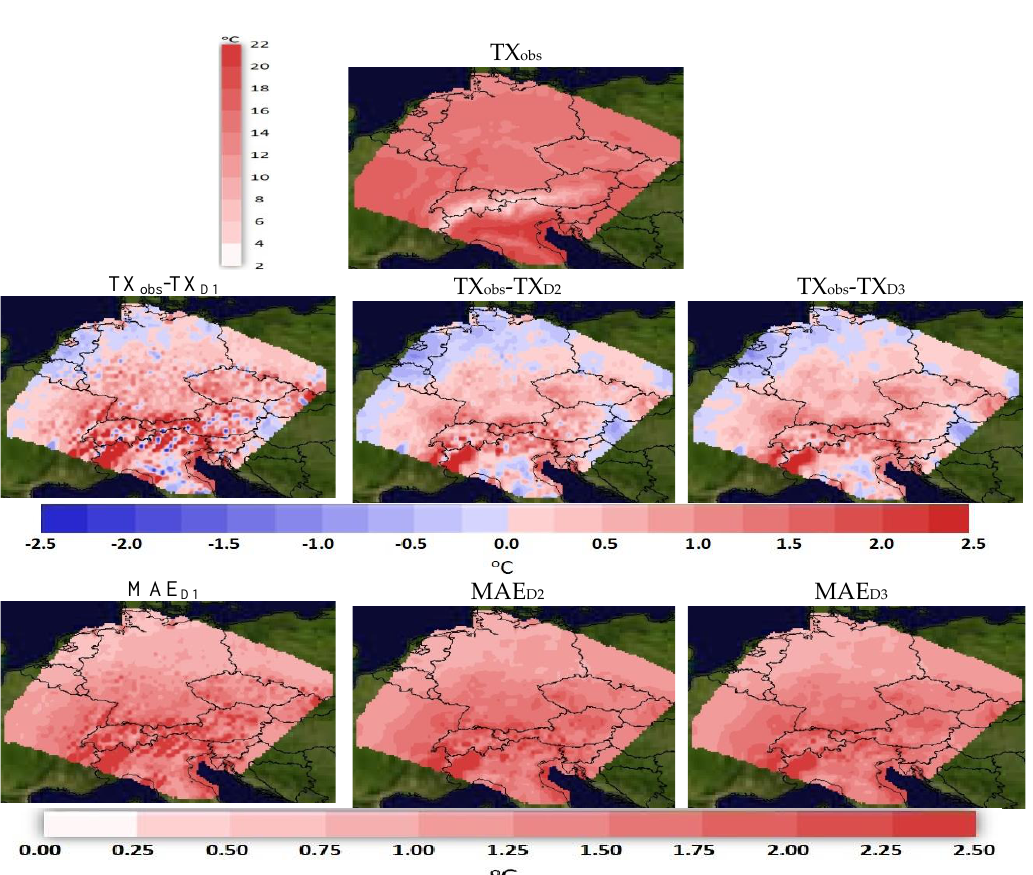
Figure 4. Spatial distribution plots for annual max temperature: observed data (upper panel), differences between observed and simulated data for the three nested domains (middle row), and the related MAE (lower row). Table 4. Annual maximum temperature statistical analysis (°C).